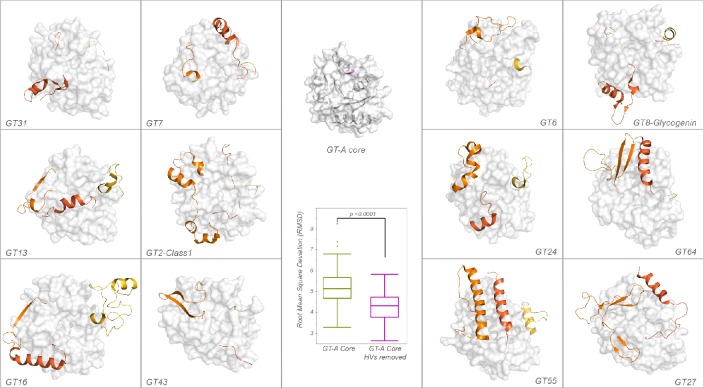
Comparison of structures for HV regions across GT-A families.The GT-A common core is shown in surface in the middle. HVs are shown in shades of orange (HV1: light orange, HV2: dark orange, HV3: orange red). Root Mean Square Deviation (RMSD) was calculated by aligning the core GT-A domains of representative structures with and without the HVs. A significant reduction in the RMSD values was observed after removing HVs that is shown in the box plot in the center. *p-value<0.0001, t-test.